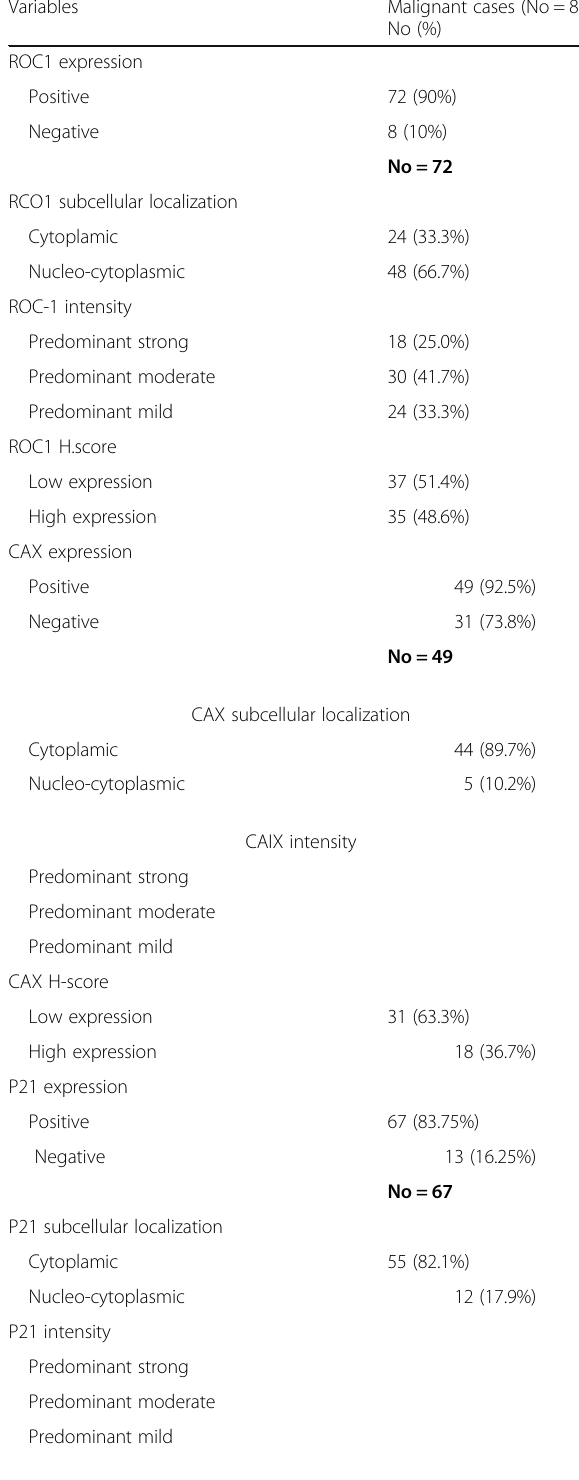
Table 2 Immunohistochemical profile of the studied ROC- 1,CAIX and p21 in the studied bladder carcinoma cases